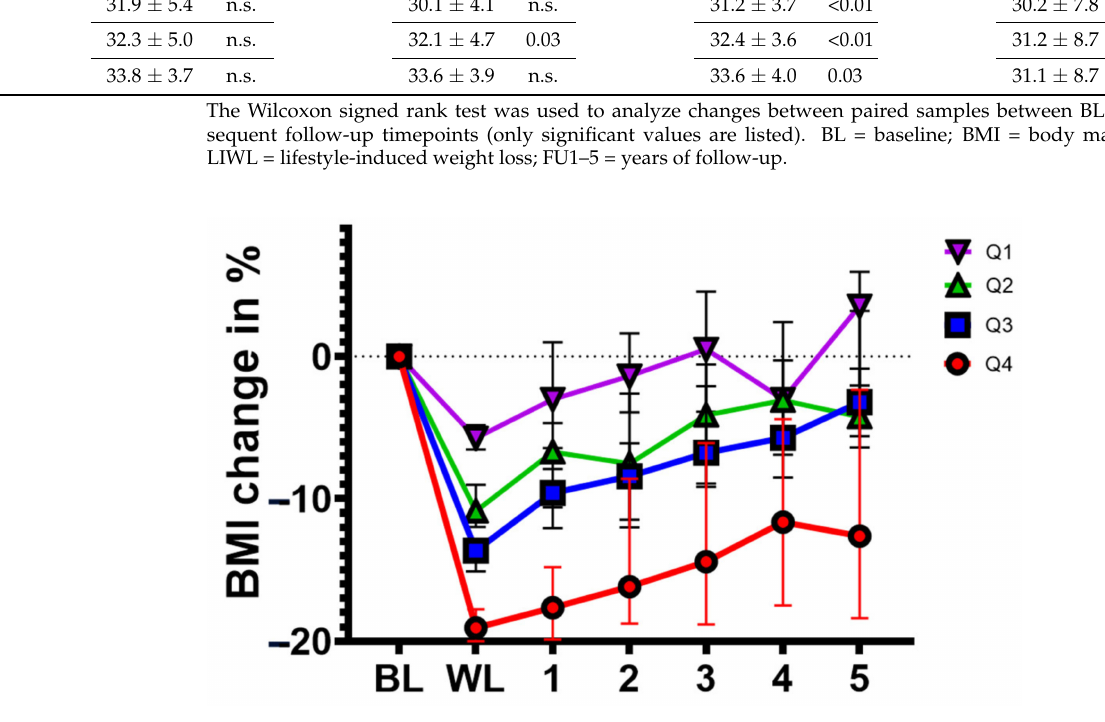
Figure 3. Absolute weight recovery is dependent on initial weight loss. Line plot summarizing changes in BMI during the 5-year follow-up in weight loss quartiles (Q1–Q4). Data are presented as the median (interquartile range). BL = baseline; WL = weight loss; 1–5 = years of